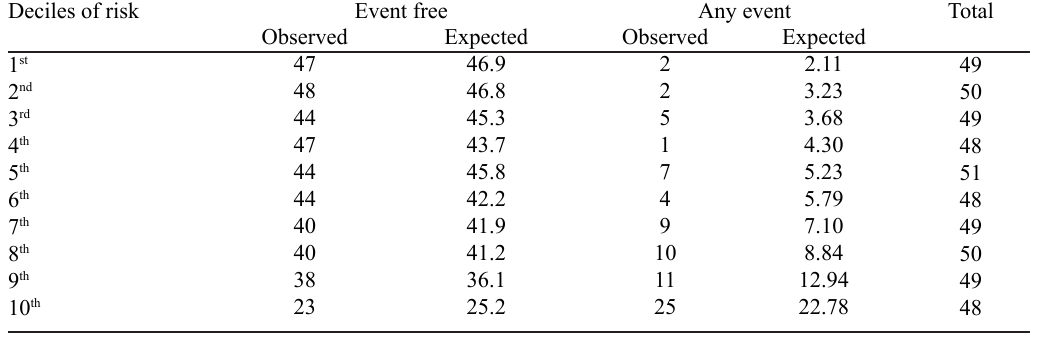
Table 3. Hosmer-Lemeshow contingence table for goodness of fit as determined for general morbidity in isolated CABG patients. Calculated Chi-square = 6.69 P =0.57.